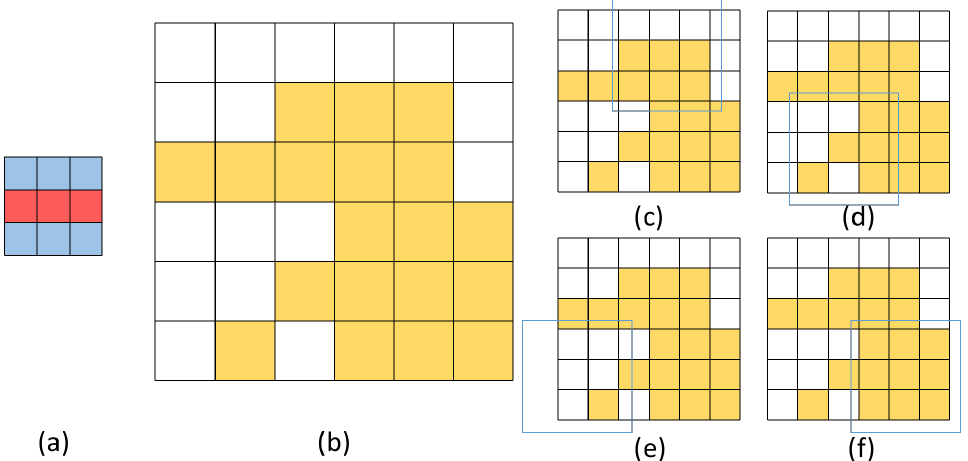
Figure 6. An example of how a local 0-degree edge-orientation neuron detects an object: ( a ) a local 0-degree edge-orientation neuron; ( b ) a random irregular object; ( c ) a 9-pixel receptive field on the edge of the object with the same degree as the local edge-orientation neuron; ( d ) a 9-pixel receptive field on the edge of the object with the different degrees with the local edge-orientation neuron; ( e ) a